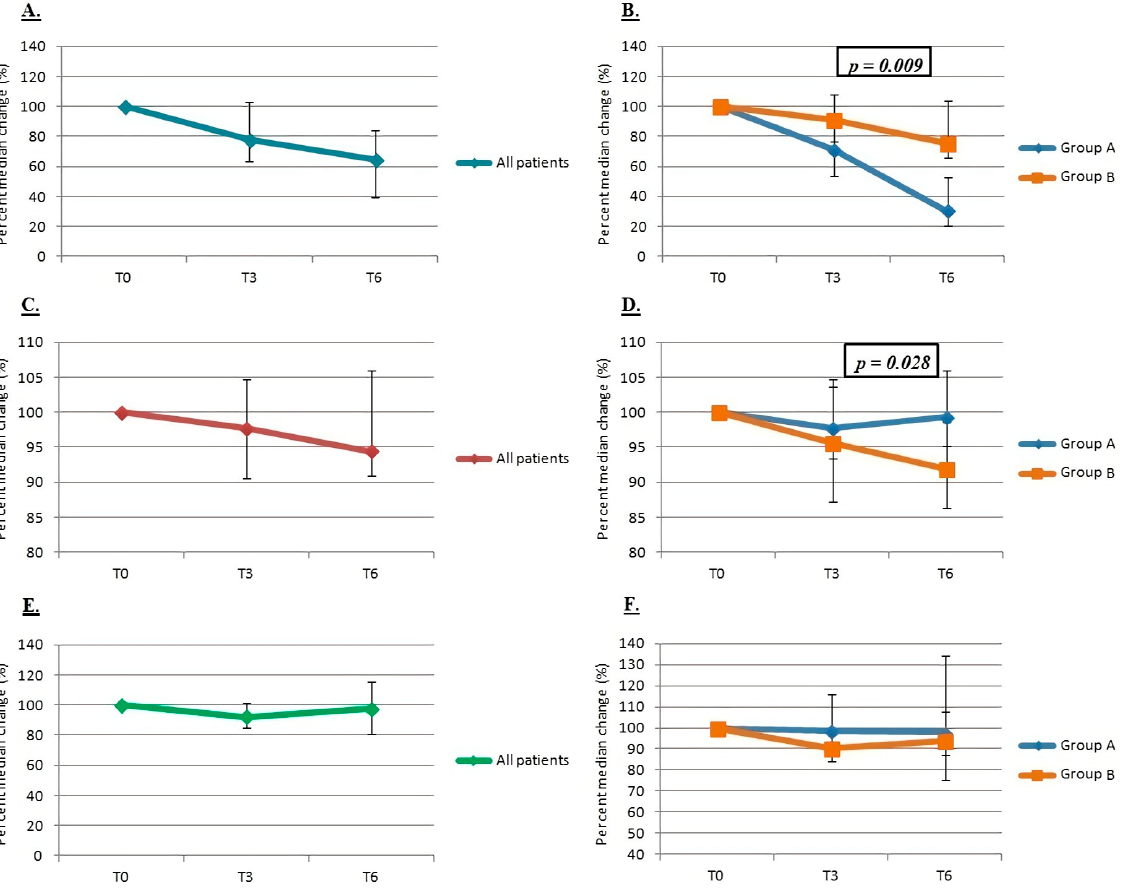
Figure 4. Percent median change in PTH (( A ) in all patients, ( B ) between the two groups), calcium (( C ) in all patients, ( D ) between the two groups) and phosphorus (( E ) in all patients, ( F ) between the two